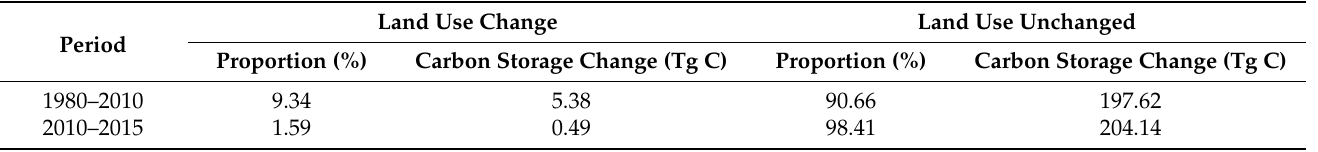
Table 5. The proportion of land use change and land use unchanged in total land and their corre- sponding carbon storage